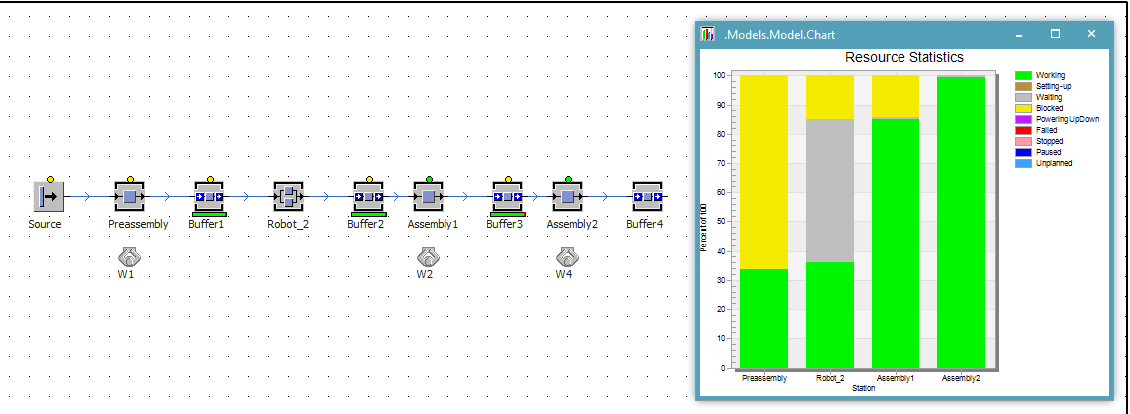
Figure 6. Variant 2a (two robots, three people).